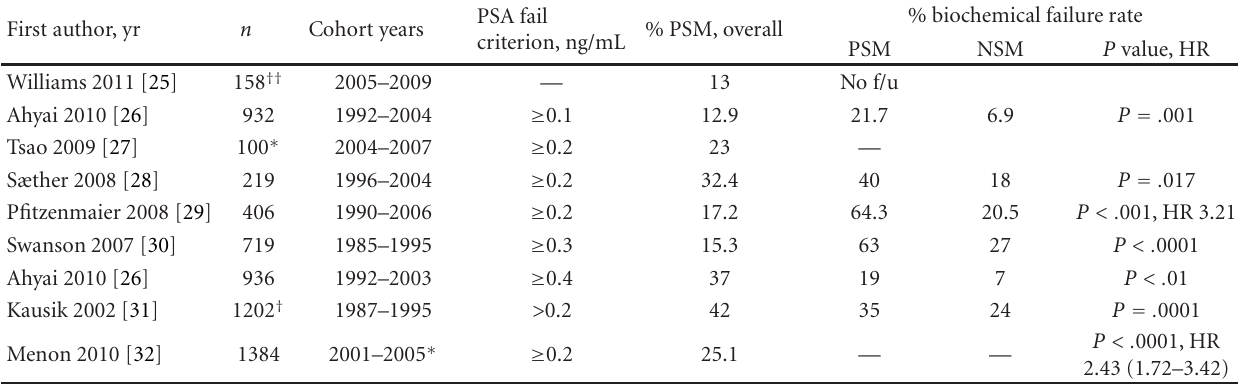
Table 3: The e ff ect of margin status on PSA failure rate at 10